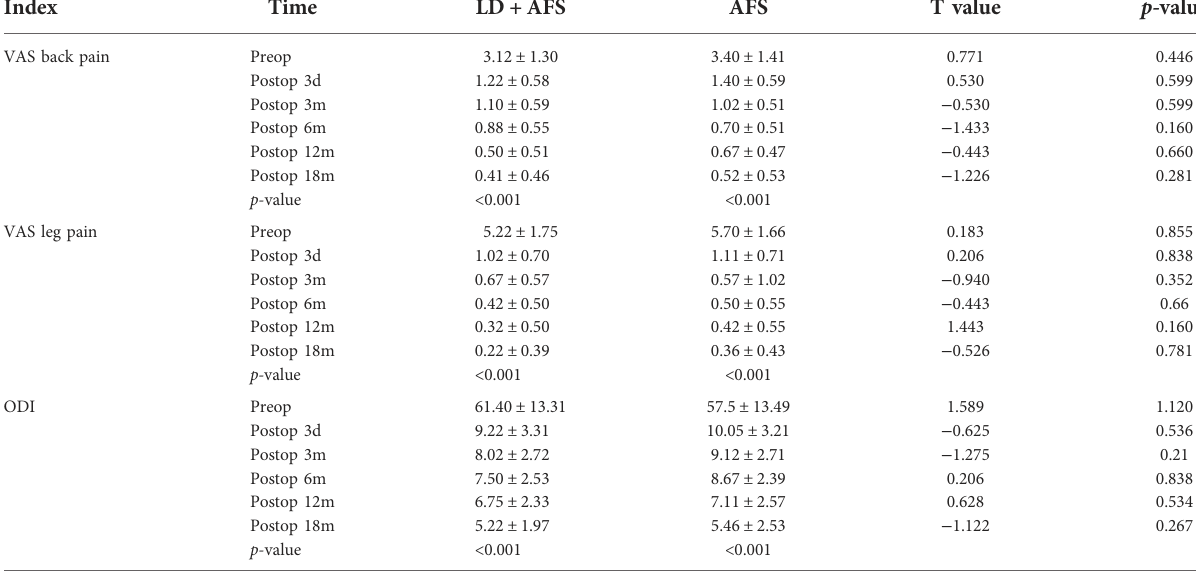
TABLE 2 Pre- and postoperative VAS and ODI scores of the two